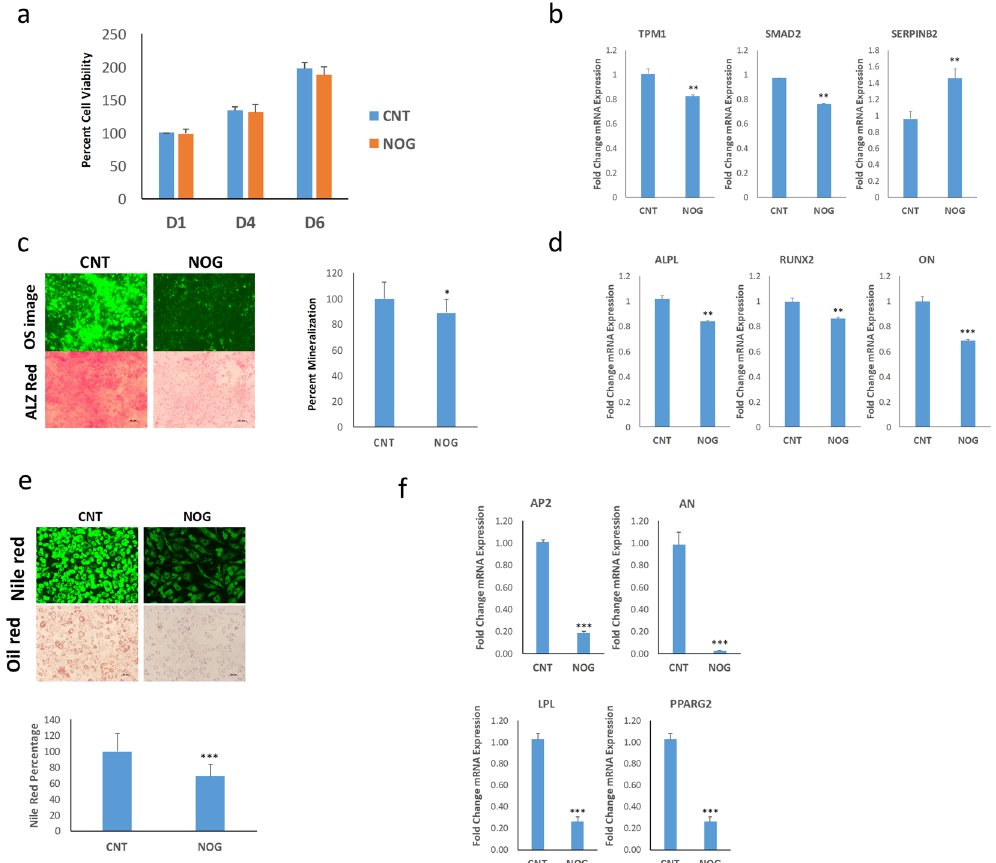
Figure 7. Exogenous NOG suppresses osteoblastic and adipocytic differentiation of hBMSC + Bone cells. ( a ) Quantification of cell viability measured on days 1, 4, and 6 for hBMSC + Bone cells in the presence or absence of recombinant NOG (50 ng/ml). (b) qRT-PCR performed for TPM1, SMAD2 and SERPINB2 TGF β responsive genes in hBMSC + Bone cells in the presence or absence of recombinant NOG (10 ng/ml). The expression of each target gene was normalized to GAPDH. Data are presented as mean ± SD from three independent experiments, ** p < 0.005. (c) OsteoImage ™ staining (20 × magnification) of hBMSC + Bone cells which were induced into the osteoblast in the presence or absence of recombinant NOG. The lower panel shows Alizarin Red S staining. The quantification of mineralized matrix formation for vehicle or recombinant NOG-treated hBMSC + Bone cells is shown (right panel). Data are presented as relative mean mineralization ± SD from three independent experiments, n = 9; * p < 0.0005. (d) qRT-PCR quantification of ALPL, RUNX2, OCN, and COL1A1 osteogenic markers in hBMSC + Bone cells in the presence or absence of recombinant NOG (10 ng/ml) under osteogenic induction conditions. The expression of each target gene was normalized to GAPDH. Data are presented as the means ± SD from three independent experiments, n = 9; ** p < 0.005, *** p < 0.0005. (e) hBMSC + Bone cells were differentiated into adipocytes for 7 days under the indicated experimental conditions. Upper panel shows fluorescence Nile red staining of mature oil filled adipocytes (20 × magnification), whilst the lower panel shows Oil red O staining for adipocytes (20 × magnification). The lower panel shows the relative quantification of Nile red staining of mature oil-filled adipocytes. (f) qRT-PCR quantification for AP2, AN, LPL and PPAR γ 2 adipocytic markers. The expression of each target gene was normalized to GAPDH. Data are presented as mean ± SD from three independent experiments, n = 9; *** p <